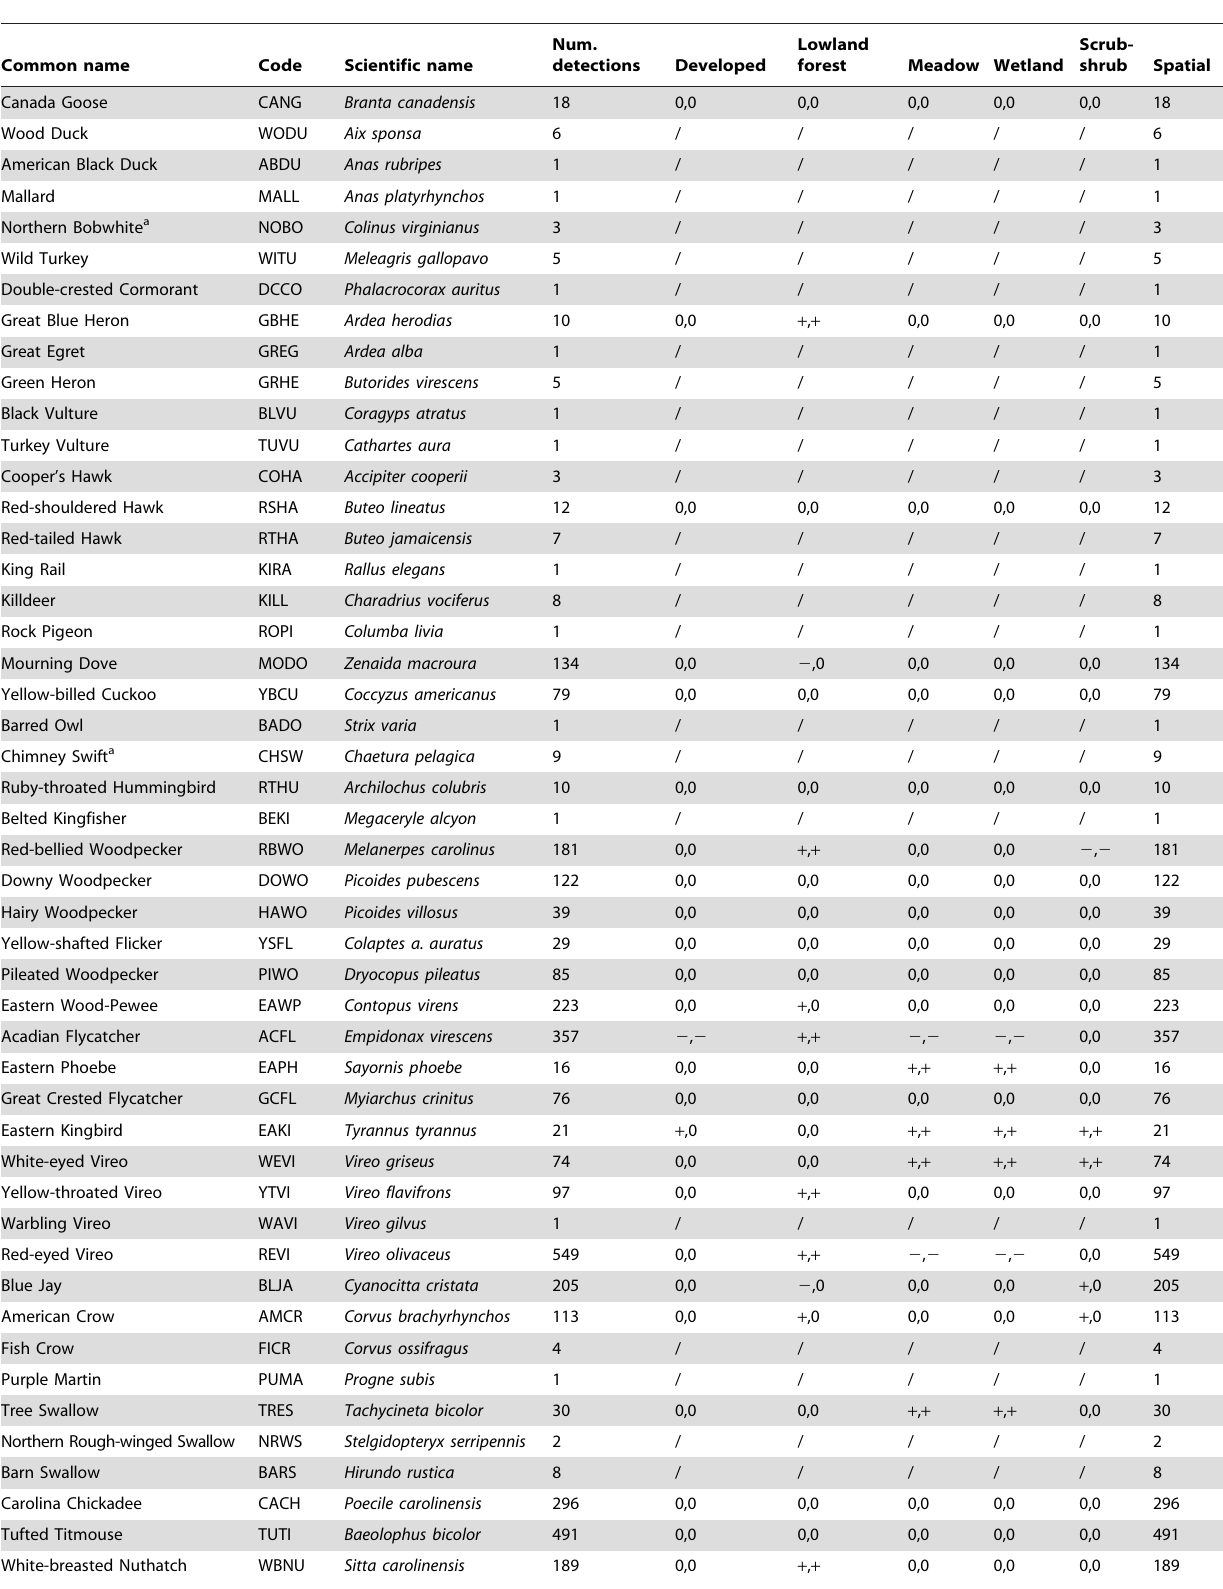
Table 2. Landcover associations and spatial autocorrelation under alternative models for distributions of bird species observed during point counts on the Patuxent Wildlife Research Refuge,